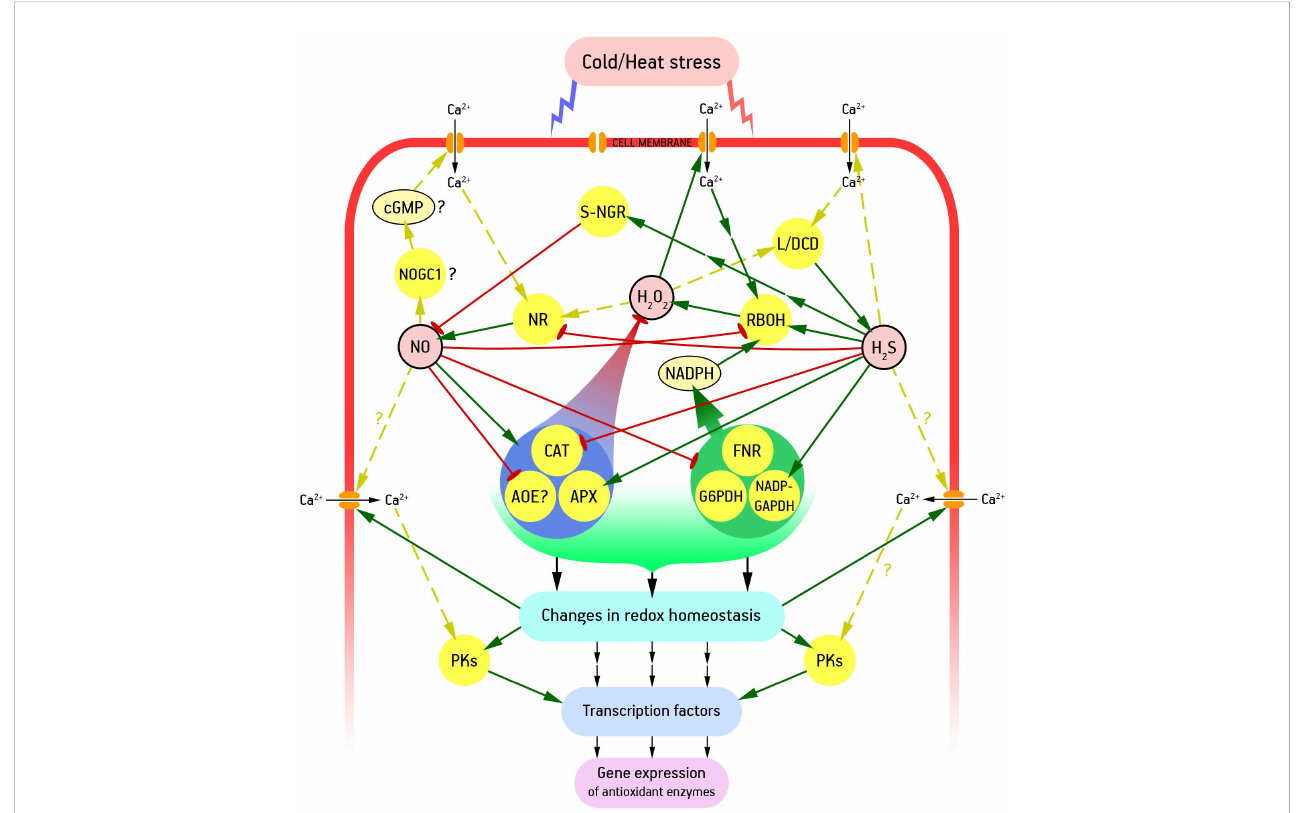
FIGURE 2 Pathways of functional interaction between H 2 S, NO, ROS and Ca 2+ in formation of plant adaptive responses to low and high temperatures. AOE, antioxidant enzymes; APX, ascorbate peroxidase; CAT, catalase; cGMP, cyclic guanosine 3 ′ -5 ′ -monophosphate; FNR, ferredoxin-NADP reductase; G6PDH, glucose-6-phosphate dehydrogenase; L/DCD, L/D-cysteine desulfhydrase; NADP-GAPDH, NADP-dependent glyceraldehyde-3-phosphate dehydrogenase; NOGC1, NO-dependent guanilate cyclase 1; NR, nitrate reductase; PKs, protein kinases; RBOH, respiratory burst oxidase homolog (catalytic subunit of NADPH oxidase); S-NGR, S-nitrosoglutathione reductase. Interrupted arrows show indirect interactions between signalling participants, and dashed arrows show interactions whose mechanisms are poorly understood. Other explanations in the